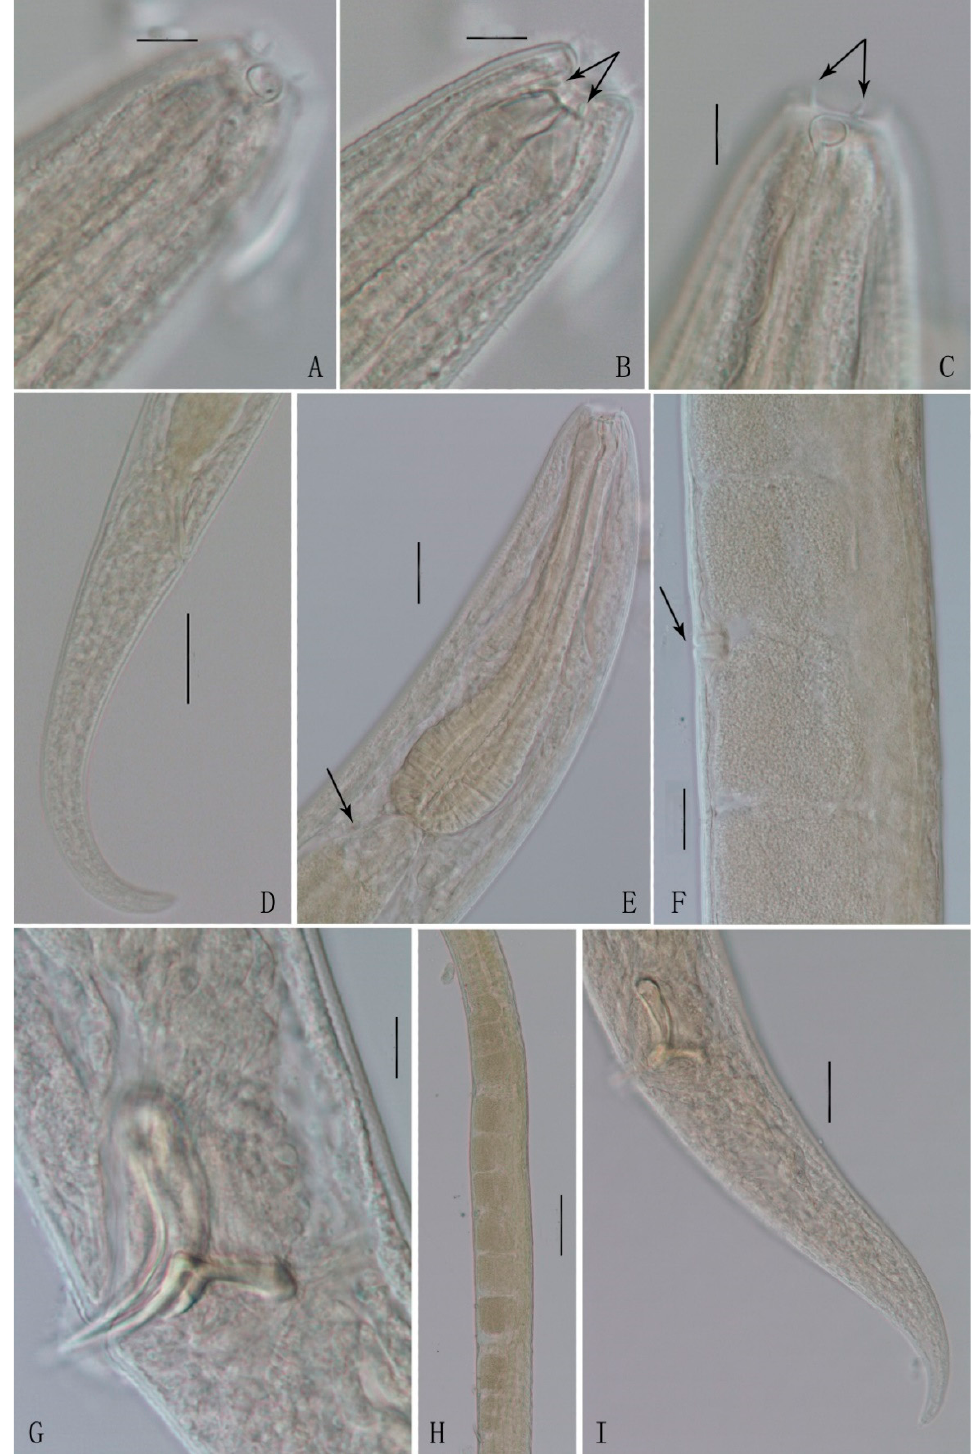
Figure 2. Anticyathus shenzhensis sp. nov.—DIC photomicrographs. ( A ) lateral view of male head end, showing amphid; ( B ) lateral view of female head end, showing buccal cavity and longitudinal reinforcements; ( C ) lateral view of female head end, showing amphid and cephalic setae; ( D ) lateral view of female tail region; ( E ) lateral view of female body part, showing pharynx and cardia; ( F ) lateral view of female body part, showing vulva; ( G ) lateral view of male body part, showing spicule, gubernaculum, and apophysis; ( H ) lateral view of female body part, showing ovary and eggs; I: lateral view of male tail region. Scale bar: ( A – C , G ) = 10 µm; ( E , F , I ) = 25 µm; ( D ) = 50 µm; ( H ) = 100 µm.